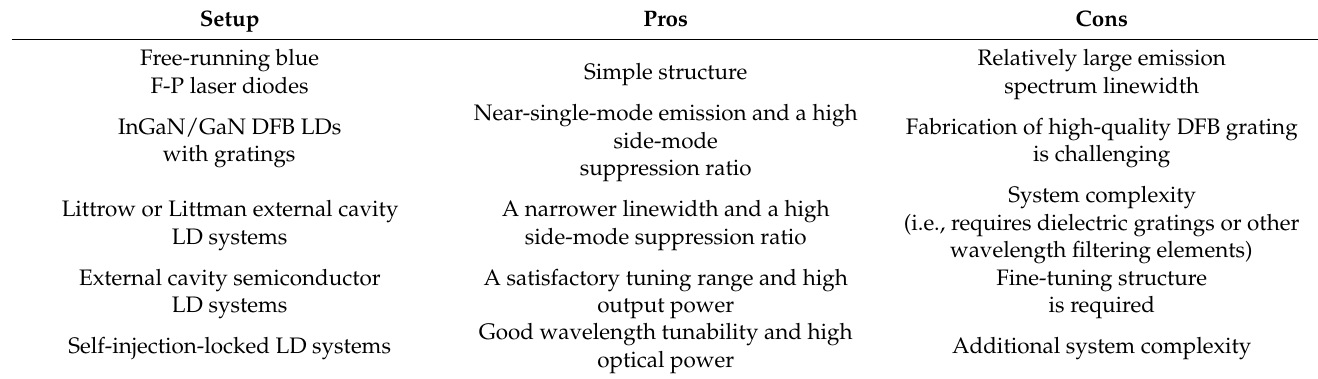
Table 1. The enhancement effects of OIL on the characteristics of different devices